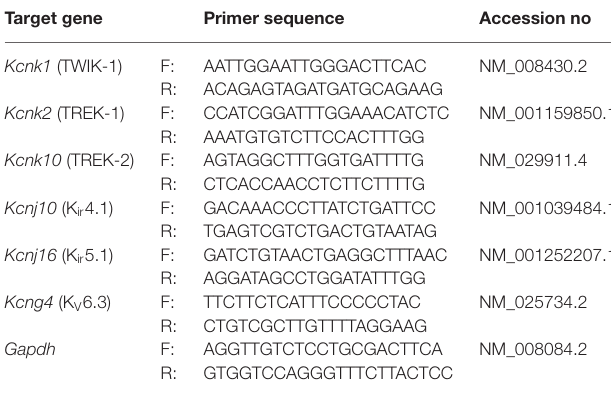
TABLE 1 | Primers for qRT-PCR